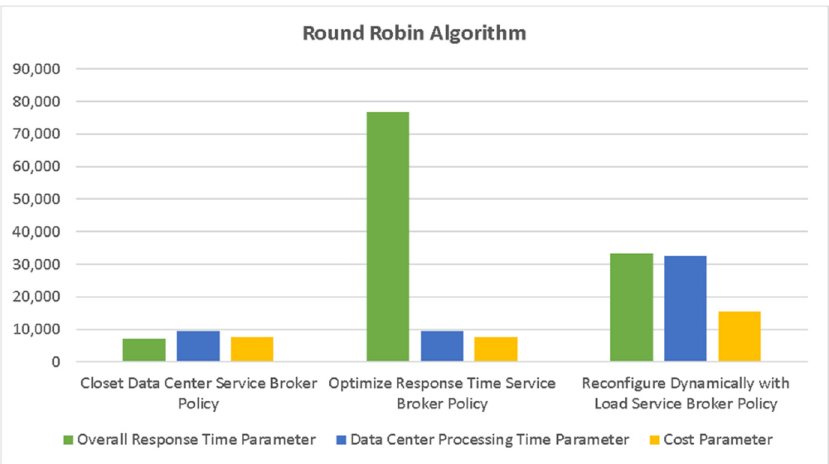
Figure 12. The analysis of the performance parameters of RR based on 3 service broker policies.